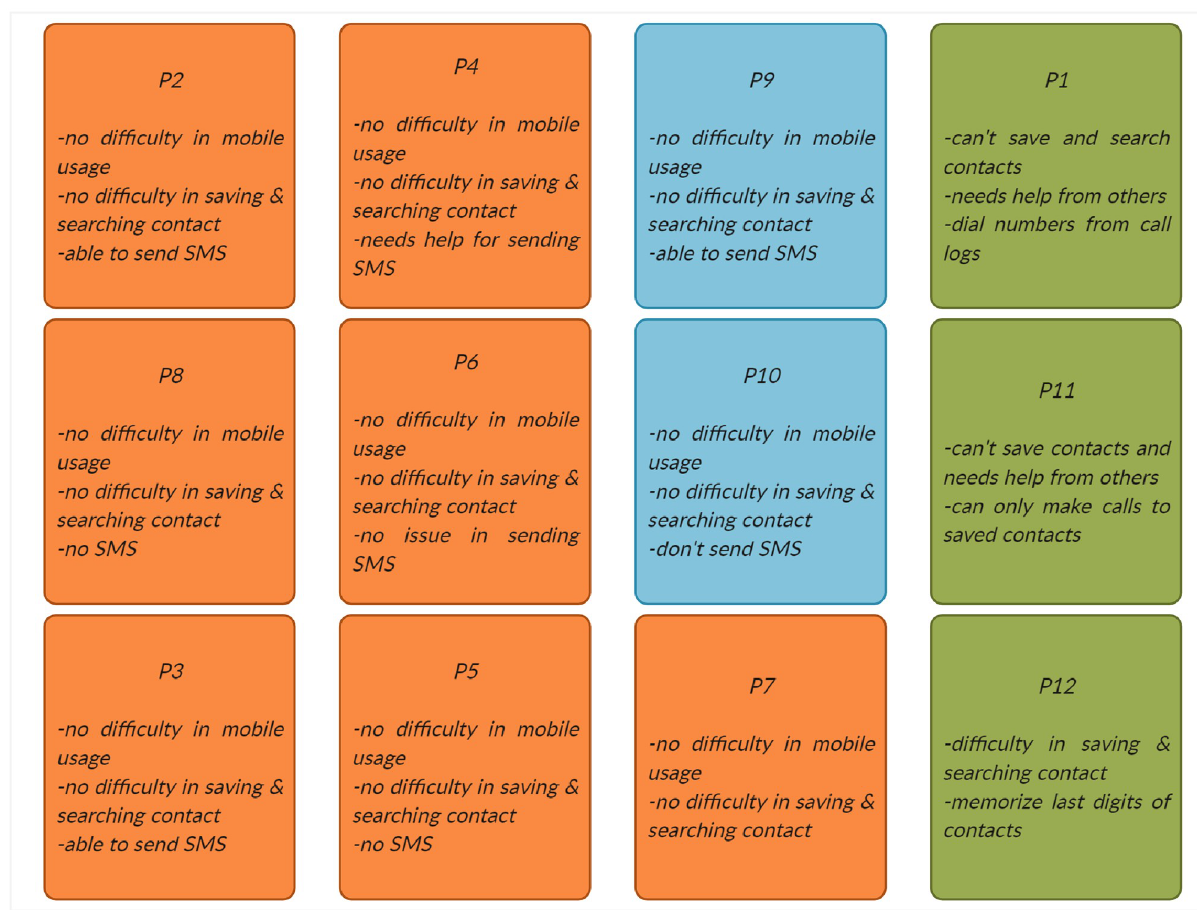
Fig 1. These affinity walls showing the results of our user study. Different emerging themes are shown with the help of different colours. Note that the demographic information of all study participants is given in Table 1.